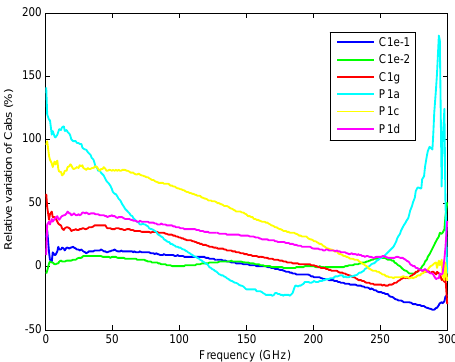
Fig. 9. Maximum relative variation of Cabs of ice crystals compared to an equal volume sphere.